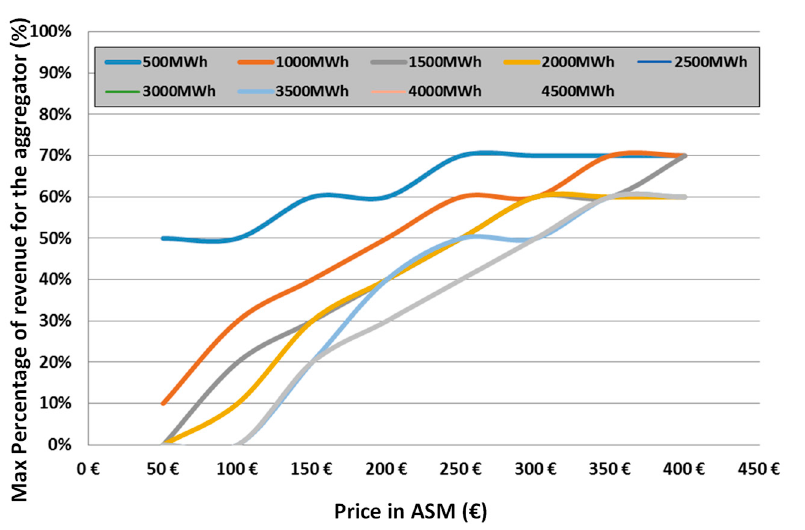
Figure 13. Comparison of the areas of profit as function of the energy exchanged—upward flexibility.